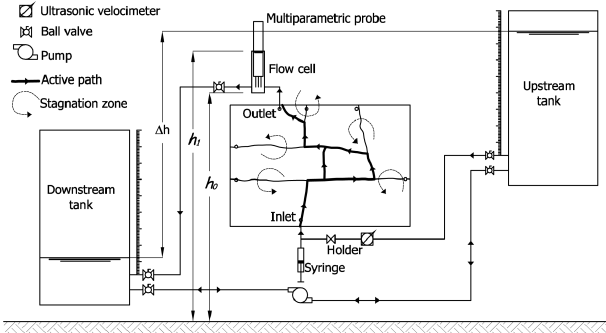
Figure 1. Schematic diagram of experimental